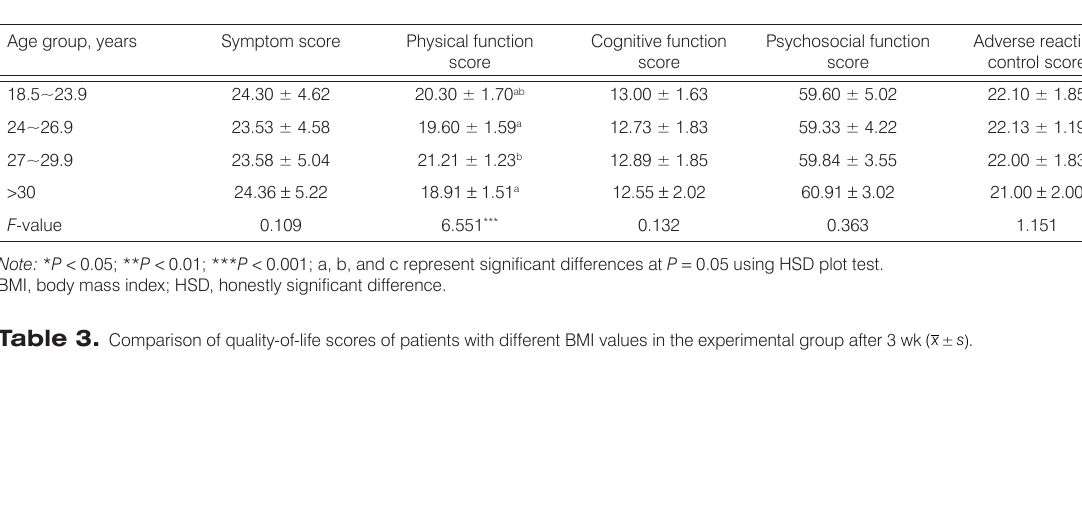
Table 2. Comparison of quality-of-life scores between the two groups ( ± ) x s .